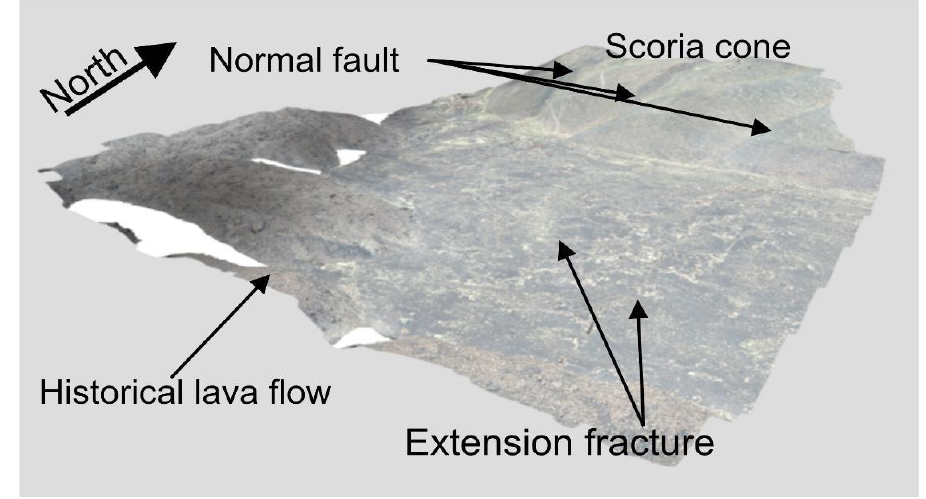
Figure 5. 3D view of the virtual geosite of Mt Pizzillo, along the NE Rift, Mt Etna.